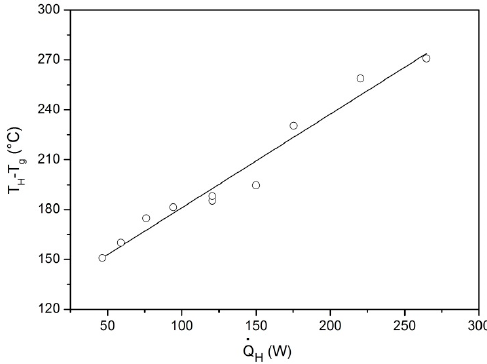
Figure 8 . The temperature difference between the hot and ambient heat exchanger with rectangular pores as a function of the input heat.